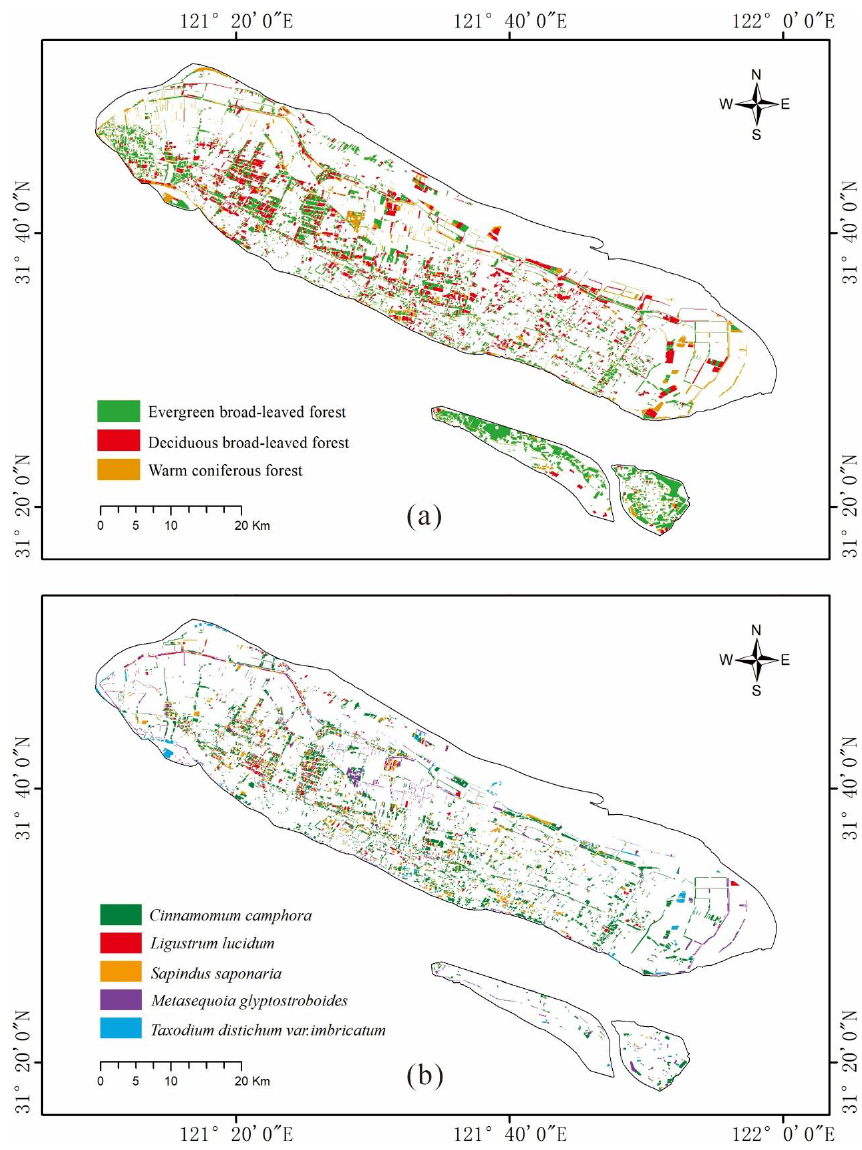
Figure 2. Spatial distributions of ( a ) three forest types and ( b ) dominant tree species on Chongming